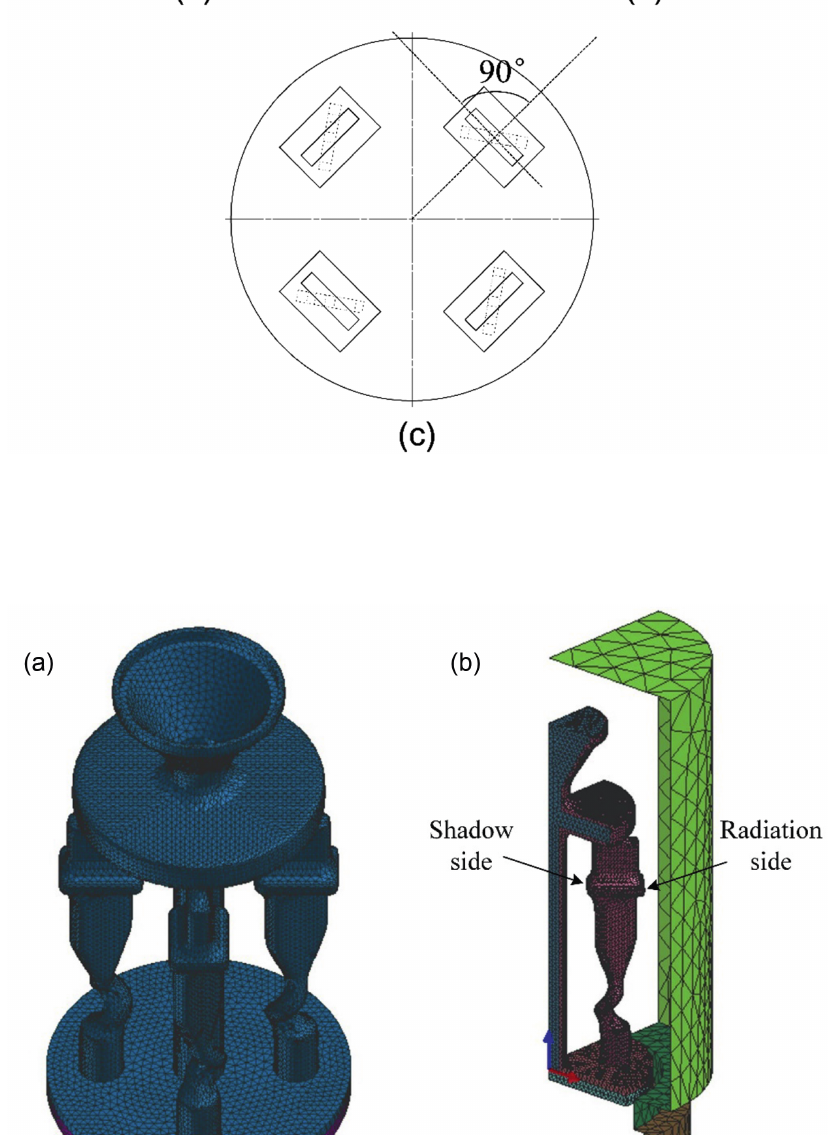
Figure 3: The mould cluster (a) A (0°), with four specimens named A1~A4, and (b) its calculation unit, a quarter of the fourfold symmetric